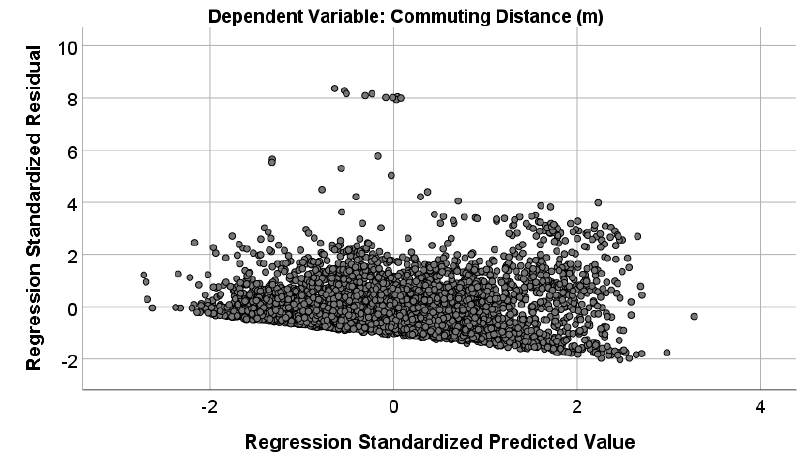
Figure 2. Heteroscedasticity of the commute distances of the sample. Table 2. Descriptive statistics of the continuous variables of the Weighted Least Squares (WLS)